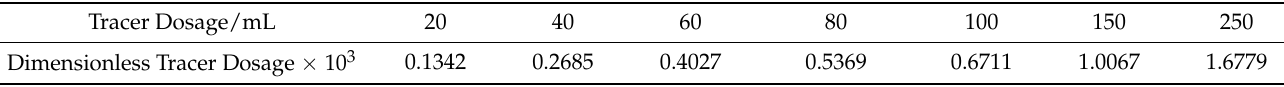
Table 3. Dosages of the KCl solution